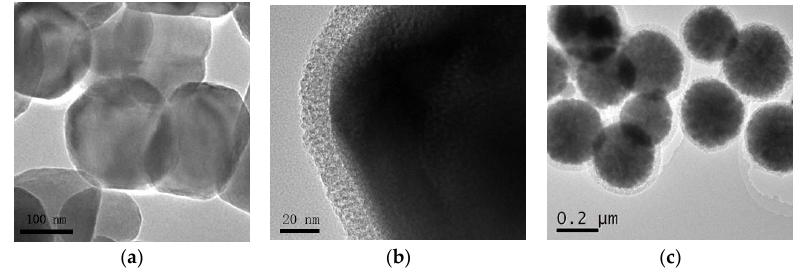
Figure 3. TEM images of ( a ) Fe 3 O 4 ; ( b ) Fe 3 O 4 @mSiO 2 ; and ( c ) Fe 3 O 4 @mSiO 2 @MIPs.